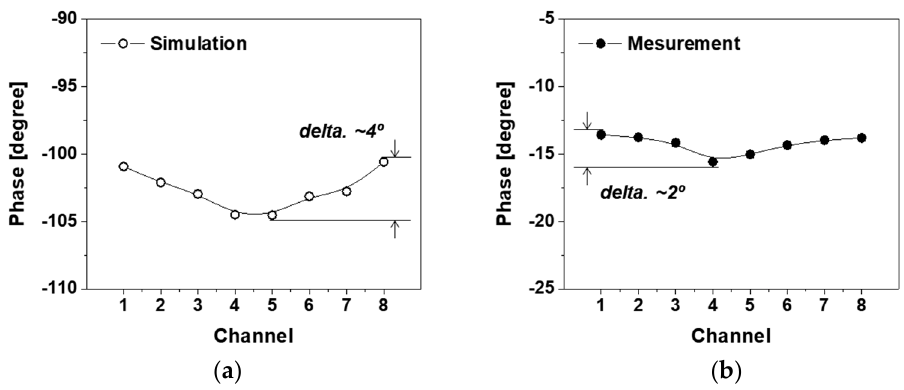
Figure 2. The phase distribution and unbalance ( a ) simulation ( b ) measurement .